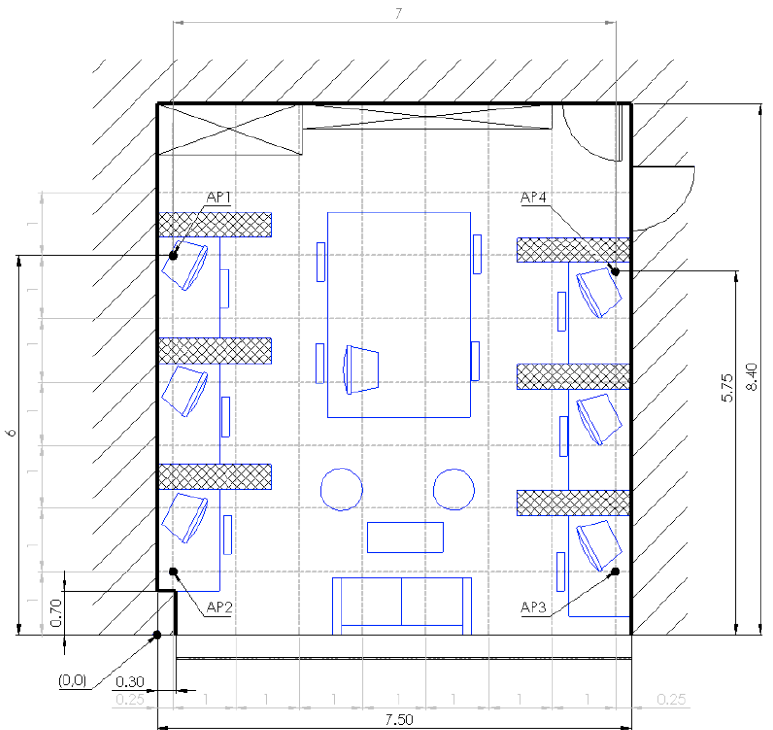
Figure 4. Evaluation environment in single room scenario.